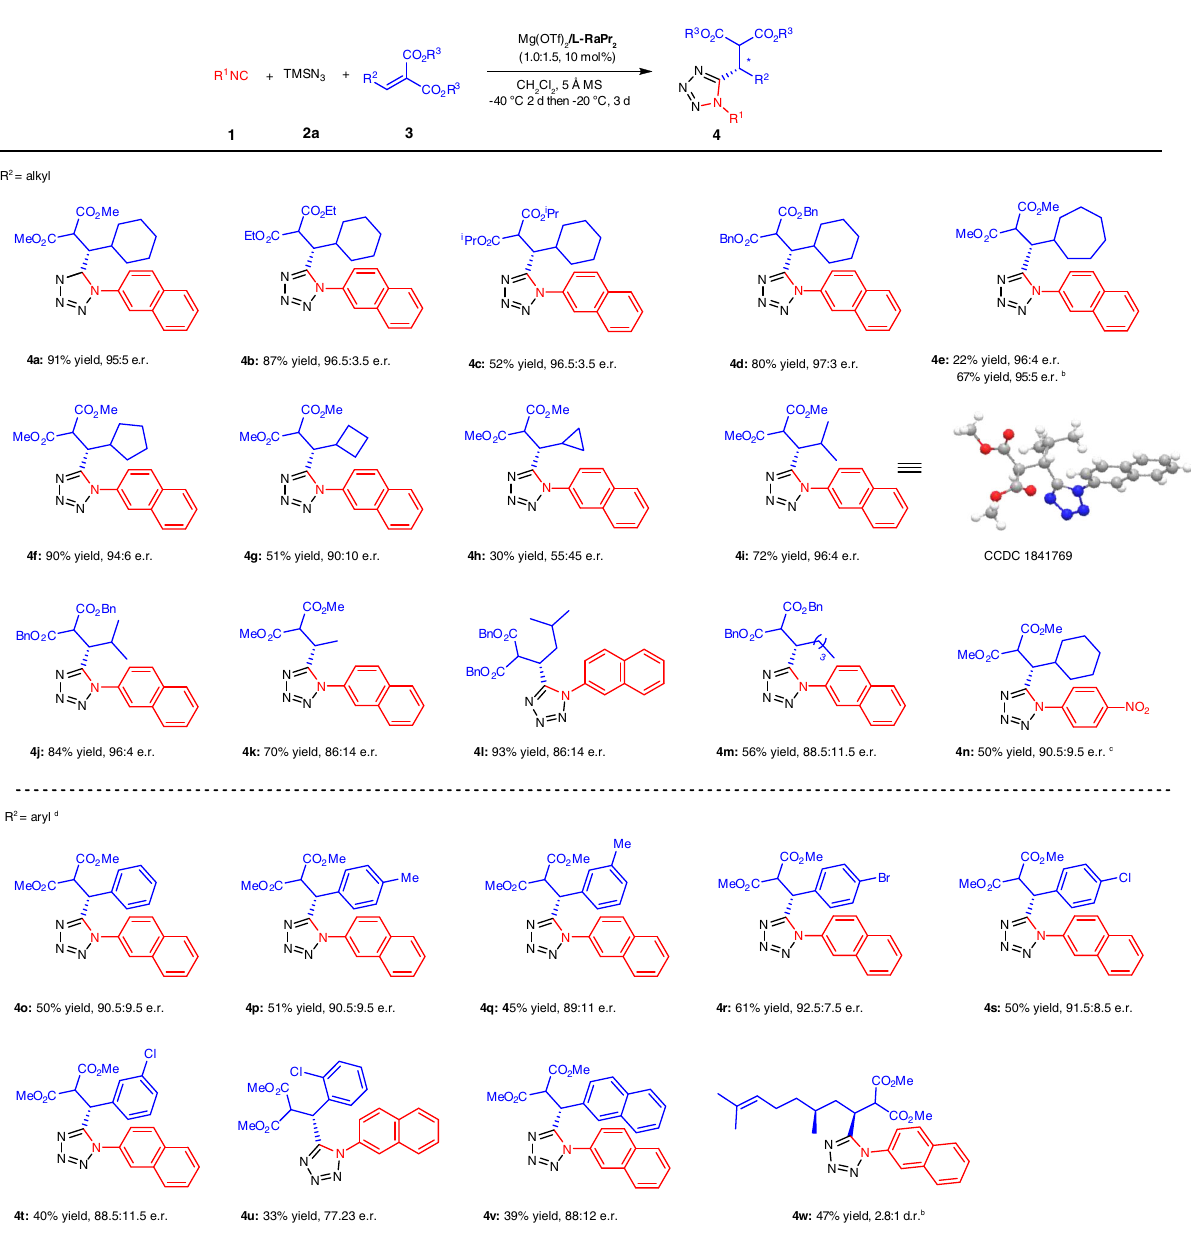
Fig. 2 Substrate scope of asymmetric synthesis three-component tetrazoles. Unless otherwise noted, all reactions were carried out with 1 (0.10 mmol), 2a (0.15 mmol), 3 (0.15 mmol), 5 Å MS (10 mg), and Mg(OTf) 2 / L-RaPr 2 (1.0/1.5, 10 mol%) in CH 2 Cl 2 (1.0 mL) at − 40 °C for 2 days, then − 20 °C for 3 days. Isolated yield and e.r. was determined by CSP-HPLC analysis. b Performed at − 10 °C. c Performed at 0 °C with Mg(OTf) 2 / L-RaPr 2 (1.0/1.0, 10 mol%). µ L), and Mg(OTf) d Carried out with 1 (0.10 mmol), 2a (0.15 mmol), 3 (0.10mmol), H 2 O (5 2 / L-RaPr 2 (1.0/1.0, 10 mol%) in CH 2 Cl 2 (1.0 mL) at 30 °C for 2 zwitterionic intermediates were captured by carboxylic acid, the utility of these species in cycloaddition reactions is rather limited.